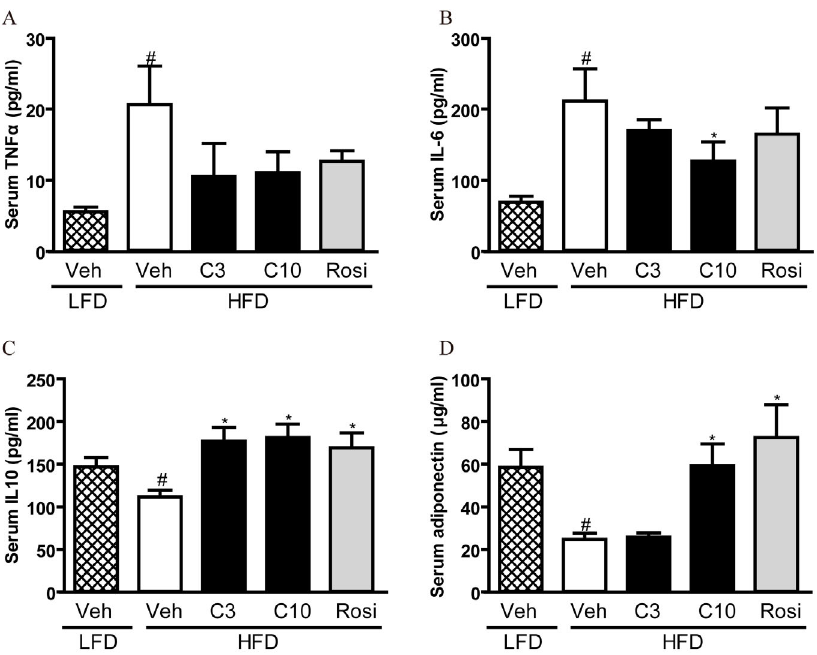
Figure 6. CMHX008 improves HFD induced systemic inflammation. C57BL/6 mice were fed with HFD or LFD for 16 weeks. Then HFD fed C57BL/6 mice were treated with CMHX008 (3 and 10 mg/kg, HFD-C3 and HFD-C10), rosiglitazone (3 mg/kg, HFD-Rosi) or vehicle (HFD-Veh or LFD- Veh) only, for additional 5 weeks. Trunk blood was collected at the end of the experiment. Serum was used for the measurement of TNF- a (A, IL-6 (B), IL-10 (C), and adiponectin (D). Data are the means 6 S.E.M., n=4–5; # P , 0.05 vs LFD-Veh and * P , 0.05 vs HFD-Veh.